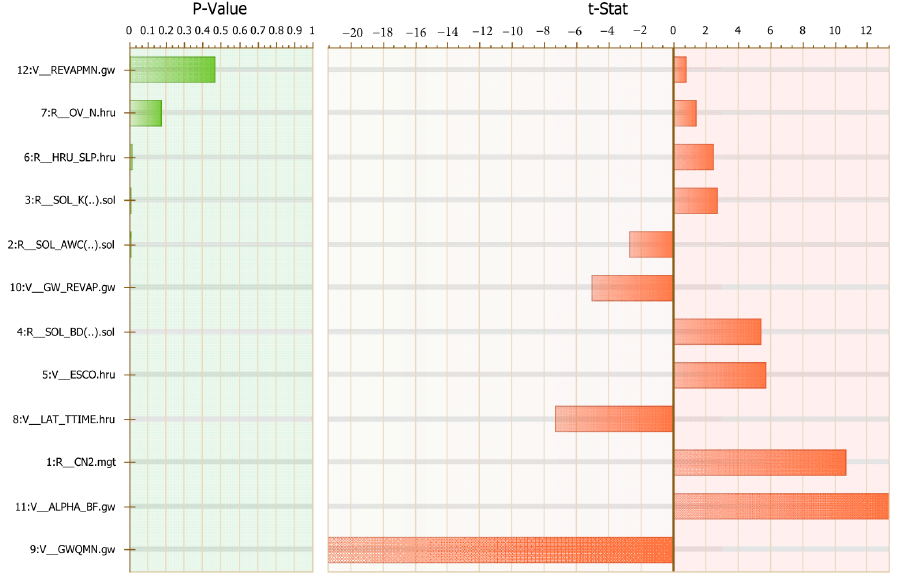
Figure 5. Graphical result of the sensitivity analysis.